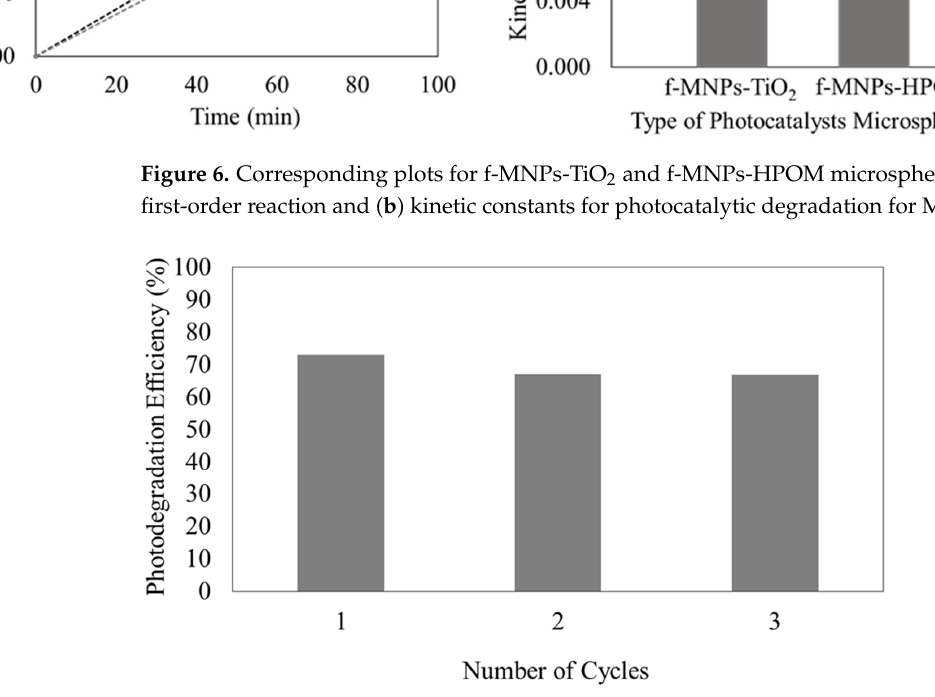
Figure 7. Photocatalytic removal efficiency in reusability cycles of f ‐ MNPs ‐ HPOM microspheres.